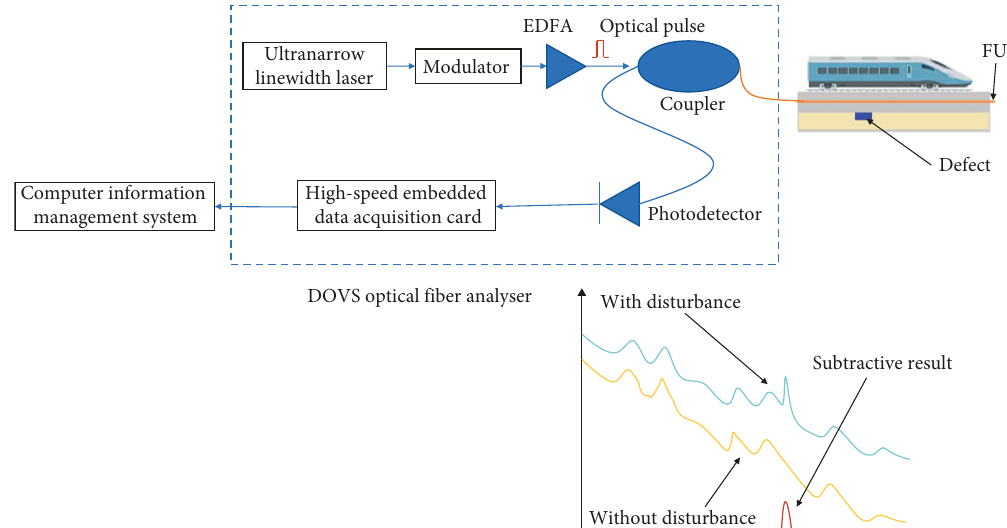
Figure 1: Structure of an OTDR-distributed optical fiber vibration sensing system.